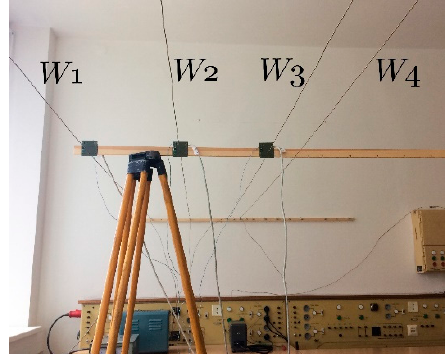
Figure 2. Measurement setup with W 4 at 10 cm from W 3 .